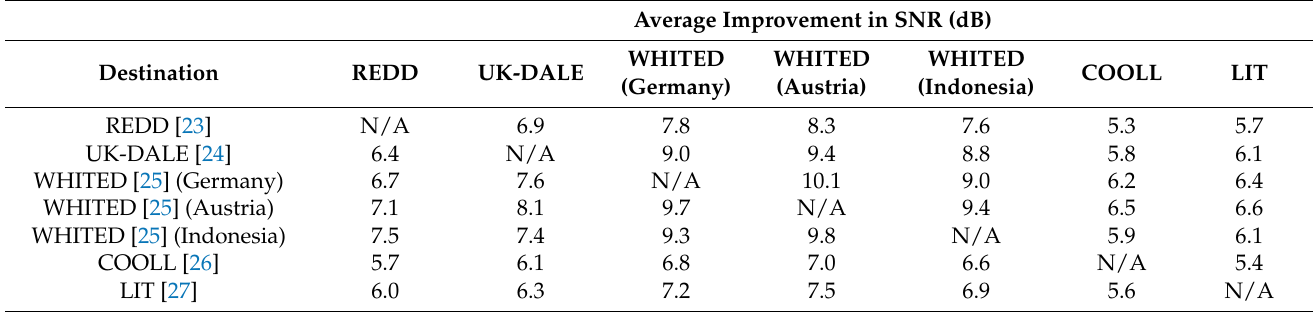
Table 3. Average improvement in SNR with CEEMD–WPT (with fixed controlled coefficients). Average Improvement in SNR